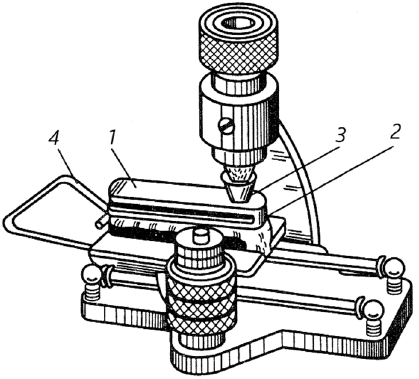
Figure 1. The schematic diagram of the PT-4 apparatus: 1 , a film sample; 2 , the apparatus stage; 3 , the rubber stopper; 4 , the stage handle.